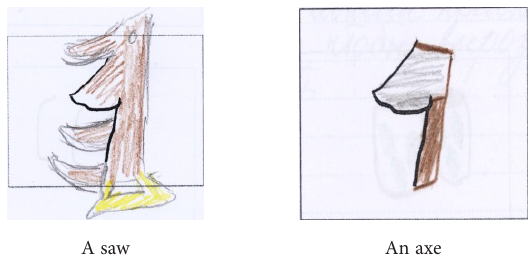
Figure 23. The creative task: interpretation of Fragment 3 – working tools (source: testingmom.com, 2020) The associations of Fragment 3 were related to working tools (a saw) by only one 22- year old first-year student from Latvia and in the process of interpretation this motif was identified twice. A group of interpreters who envisaged working tools was supplemented by a first-year student of Russian origin from Latvia, who linked the presented fragment with the nose in the process of association and drew a working tool (an axe) in the process of interpretation (Figure 23).